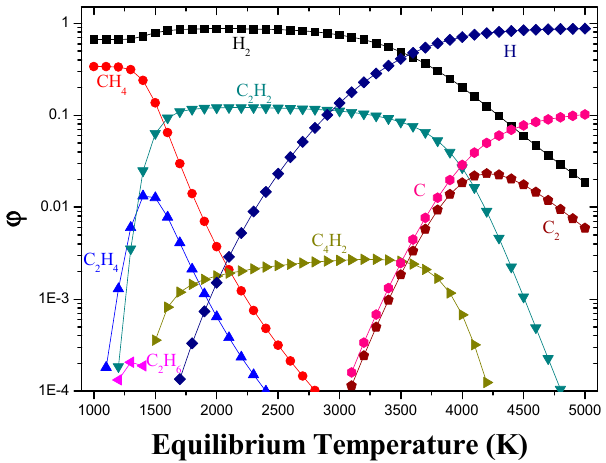
Figure 2. Thermodynamic simulation of PE pyrolysis in equilibrium model.